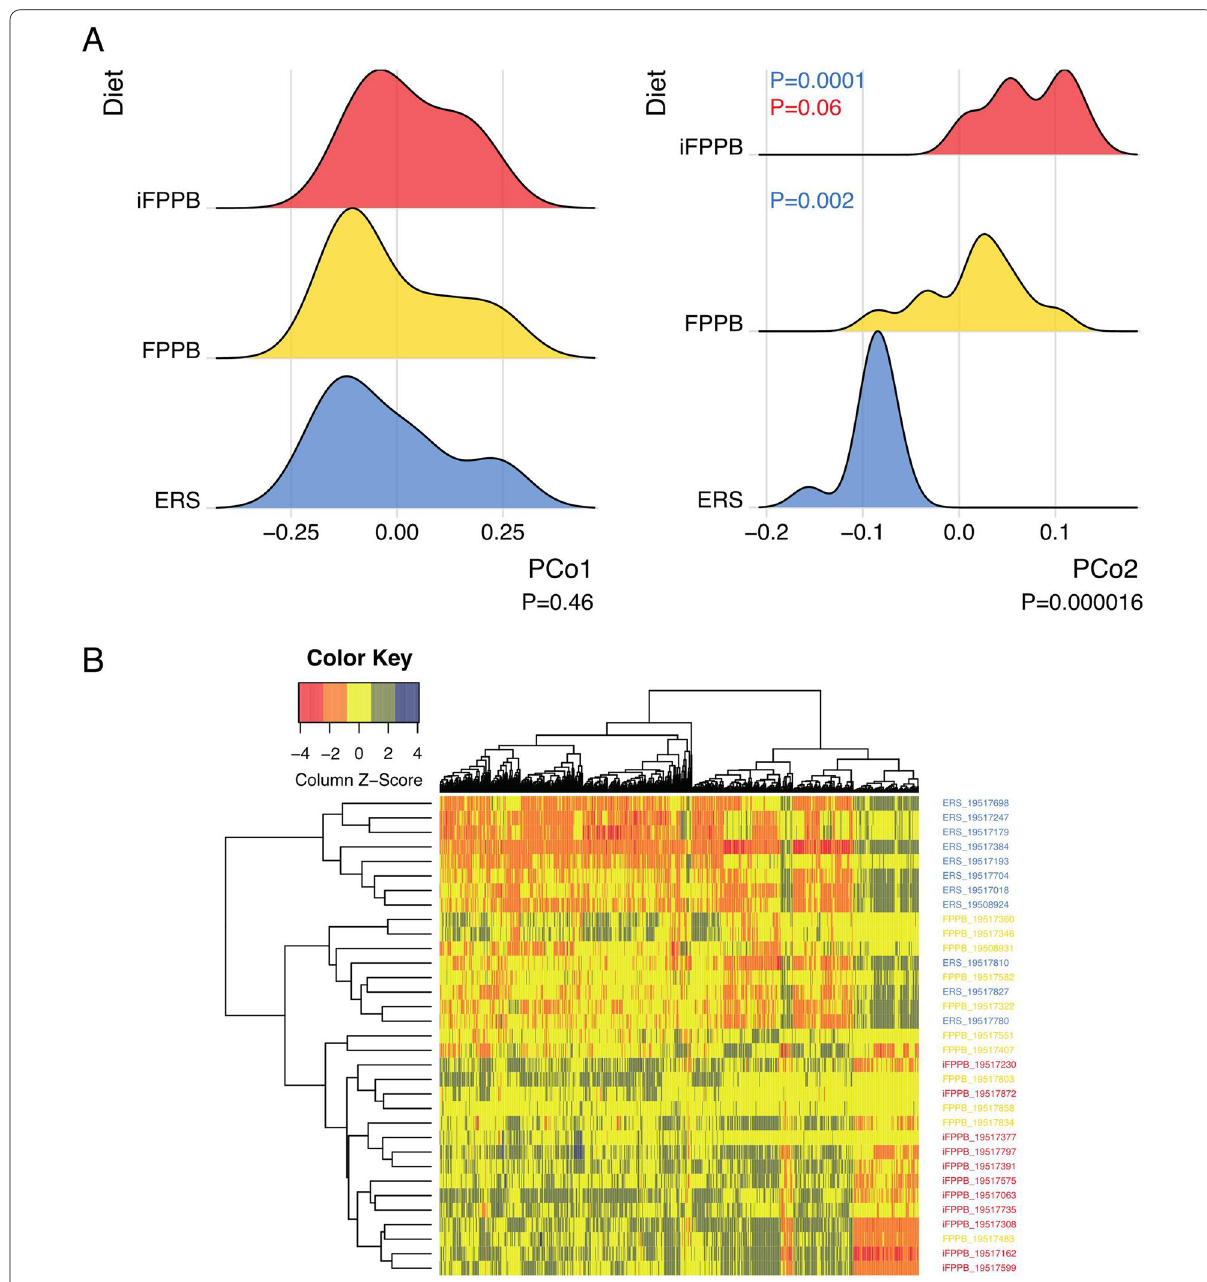
Fig. 4 Principal coordinate analysis (PCoA) and heatmap of Kyoto Encyclopedia of Genes and Genomes (KEGG) orthology (KO) terms of fecal samples collected from cats fed the experimental diets. The data show a significant shift in KO term relative abundance between the diet groups, indicating gut bacterial functions changed in response to diet. The Kruskal–Wallis test was used to assess the association between diet and the top two PCo axes followed by Dunn’s post-hoc test to evaluate the difference between groups. A No significant differences between the diet groups were observed along the PCo1 ( P > 0.05, Kruskal–Wallis test). However, strong shifts along the PCo2 was observed between the diet groups ( P < 0.0001, Kruskal–Wallis test). PCo2 scores were higher in iFPPB and FPPB groups (FDR adjusted P -values 0.0001 and 0.002, respectively, Dunn’s = post-hoc test) but they did not differ significantly between the iFPPB and FPPB groups ( P 0.06, Dunn’s post-hoc test). B Heatmap =